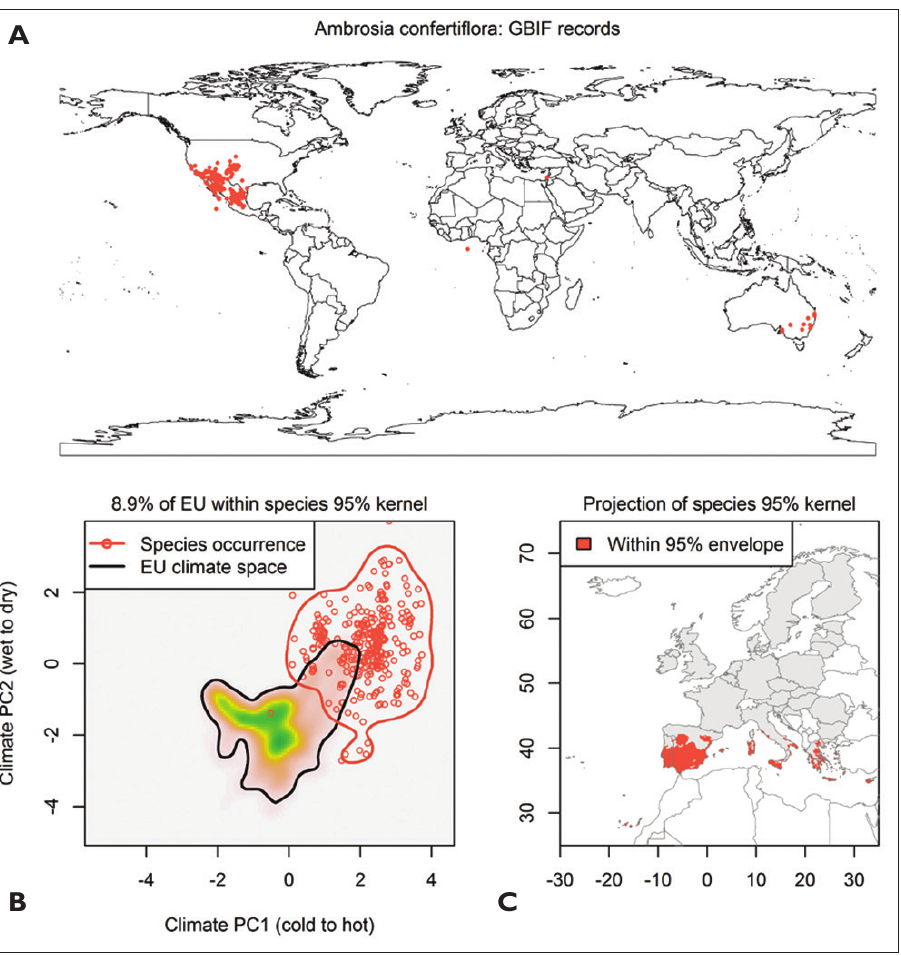
Figure 2. An example of the distribution maps and potential occurrence in Europe – Ambrosia confer- tiflora . A Global occurrence locations were obtained from the Global Biodiversity Information Facility B The global climate was summarised as two principal components analysis (PCA) axes on the 19 World- Clim layers (Hijmans et al. 2005). Species occurrences were plotted in this climate space and a bivariate normal kernel density model (Calenge 2006) was used to estimate ‘climate envelopes’ at different percen- tiles C These envelopes were then projected onto geographic space in the EU. Shading indicates these percentiles, with smaller numbers indicating higher density of